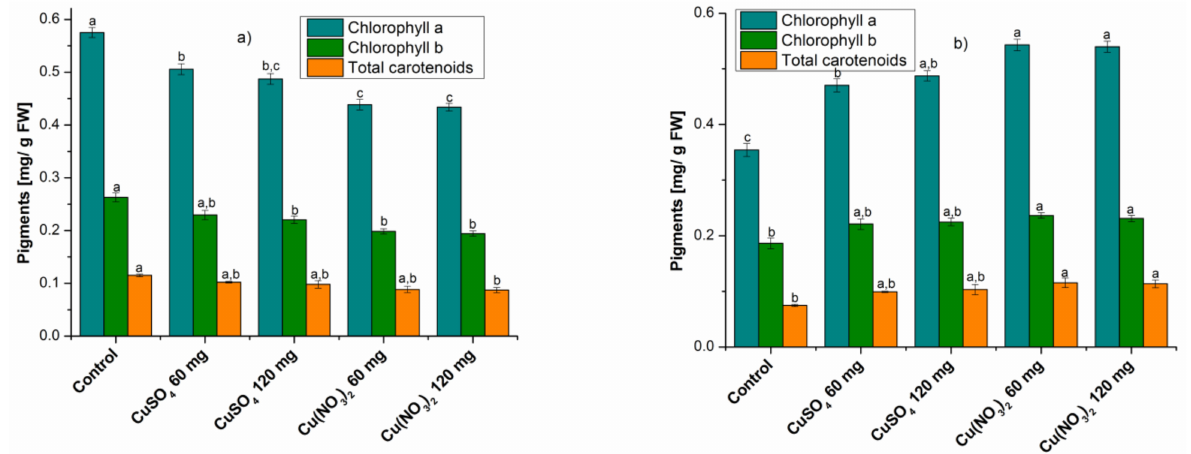
Figure 1. Comparative diagram of the pigment content; ( a ) at three weeks after sowing and ( b ) at six weeks after sowing. Each data point is the mean ± the standard error of the mean of three inde- pendent replicates experiments; different letters mean significant differences between the treatment and the control plants as determined by Tukey’s test ( p <